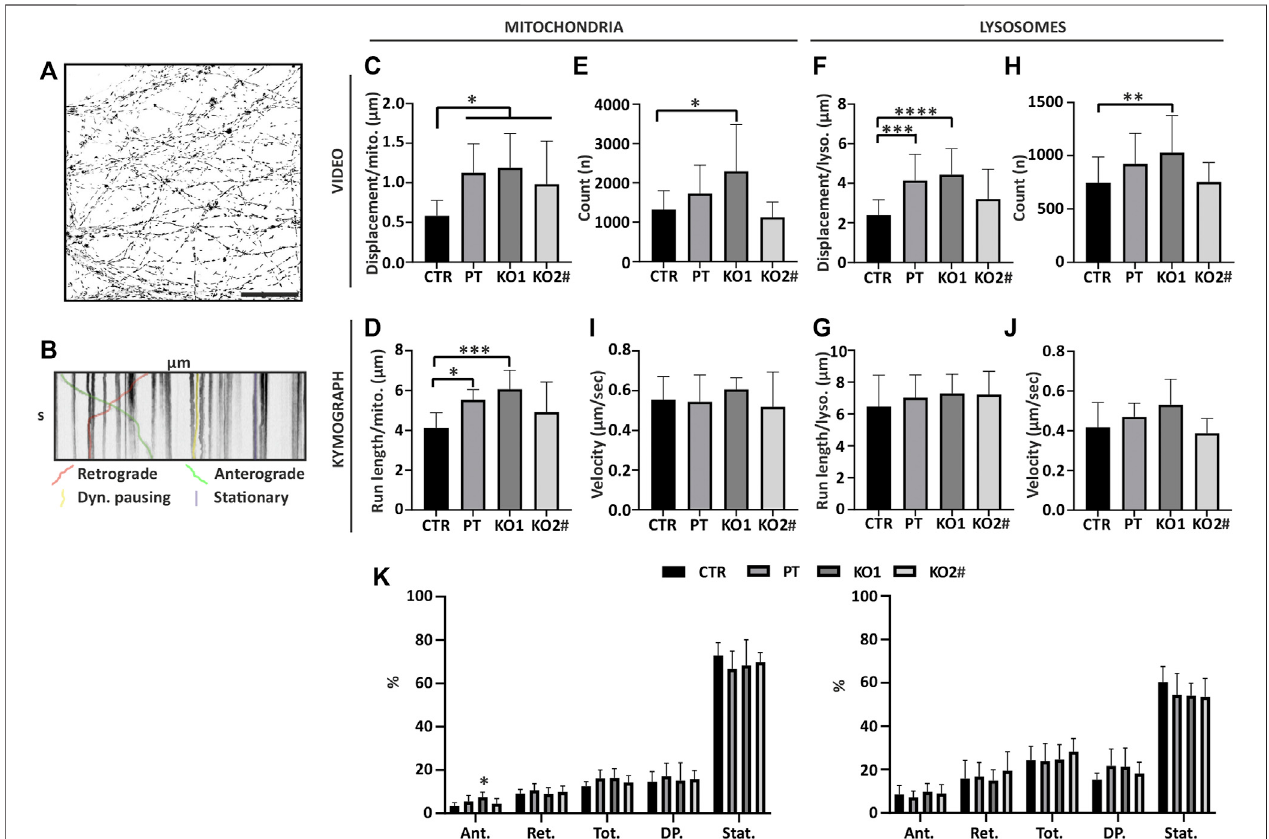
FIGURE 5 | Movement of mitochondria and lysosomes is increased in iPSC-MN axons lacking NFL. Mitochondria and lysosome movement along the axons of motor neurons reveals increased movement in PT and KO cells. (A) Mask of CTR mitochondria tracking video frame 1. Total axon mitochondrial movements by